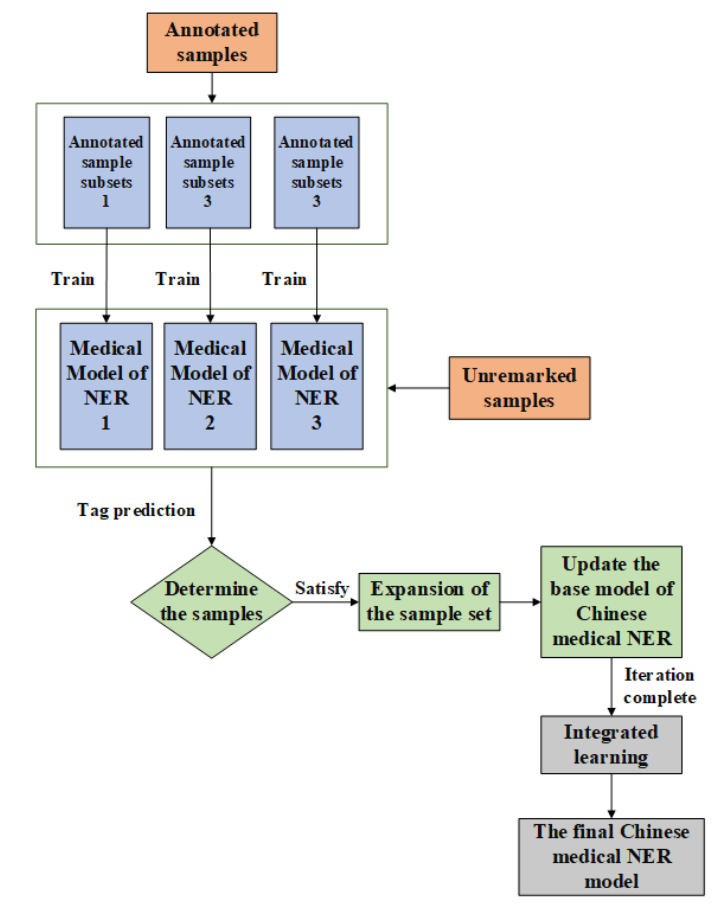
Figure 2. Structure of Chinese medical entity recognition model based on semi-supervised